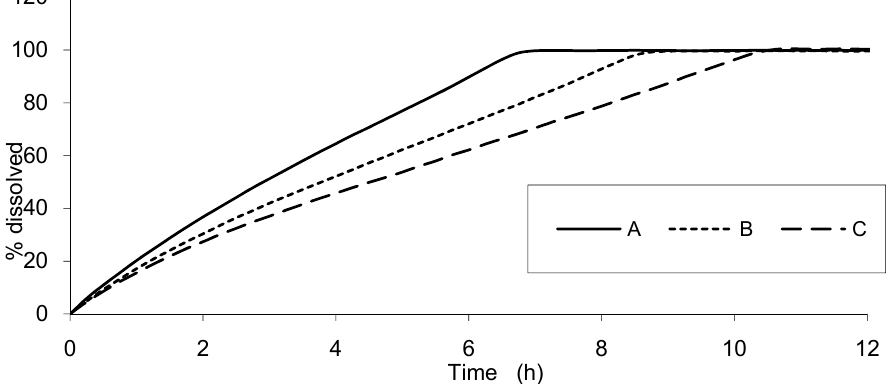
Figure 2. In vitro dissolution of the test formulations A : 6 mm, B : 7.5 mm, and C : 9 mm in USP2 pH 6.8 phosphate buffer, 50 rpm. The relative standard deviation is below 4 % at all time points. The test formulations are fully dissolved (100%) after approximately 6.5, 8.5 and 10 hours, respectively.